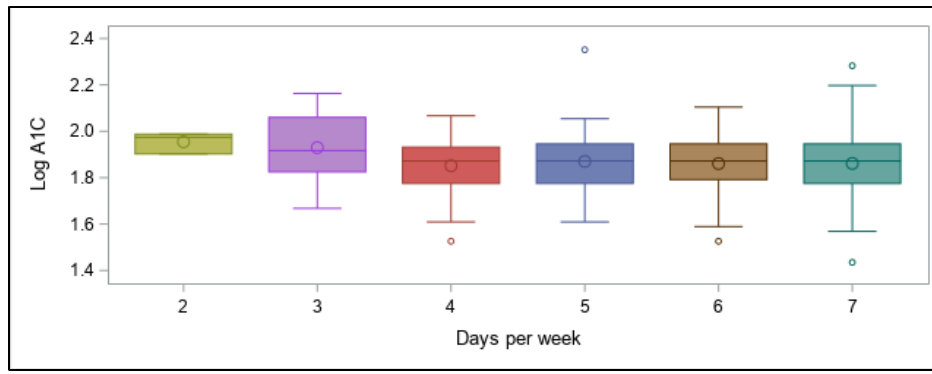
Figure 4. Number of days of physical activity per week and association with log A1C values.